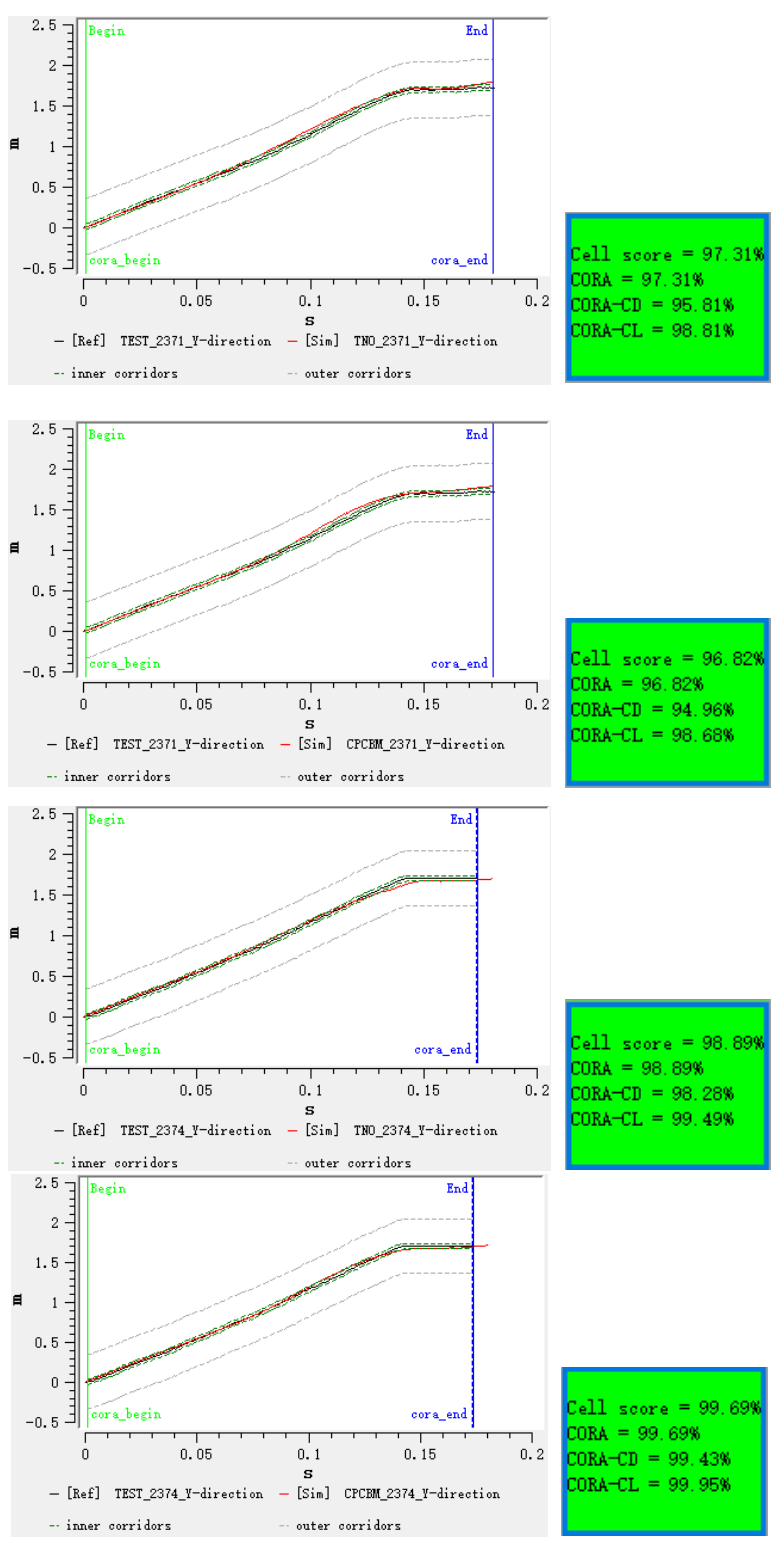
Figure A12. Y-direction displacement signals between experiment and simulation.